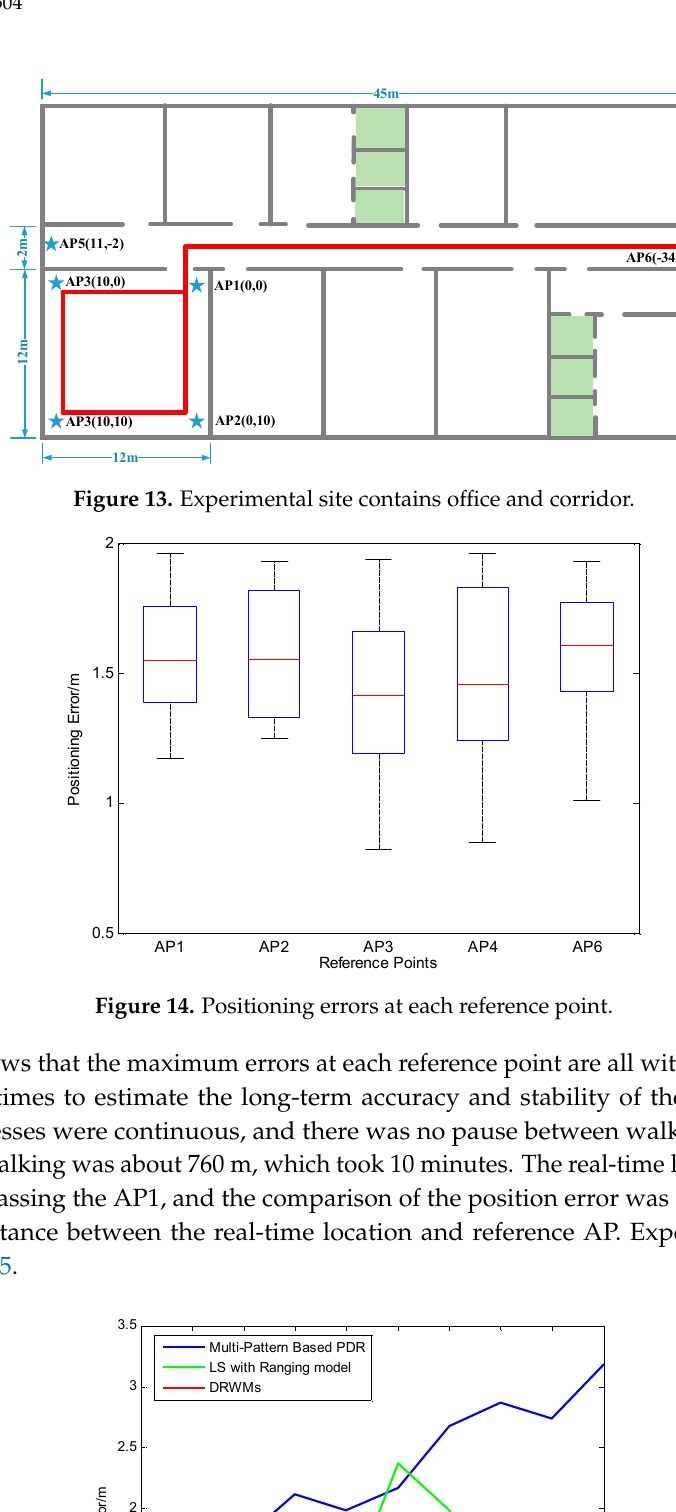
Figure 14. Positioning errors at each reference point.